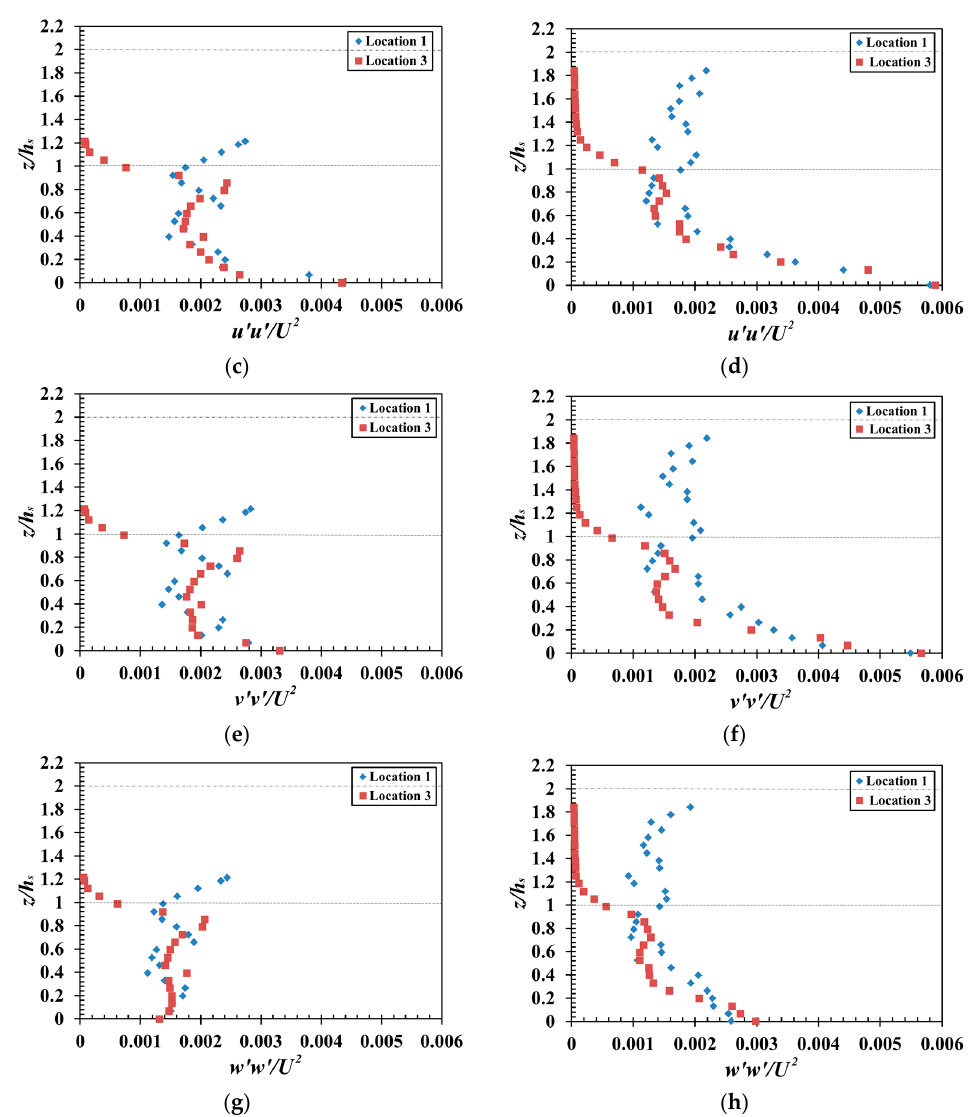
Figure 8. Simulated profiles of Reynolds stresses and normal stresses at critical typical locations (1 and 3) for Case A ( a , c , e , g ) and for Case B ( b , d , f , h ). The lower and upper dotted lines represent the top of vegetation layers 1 and 2, respectively.